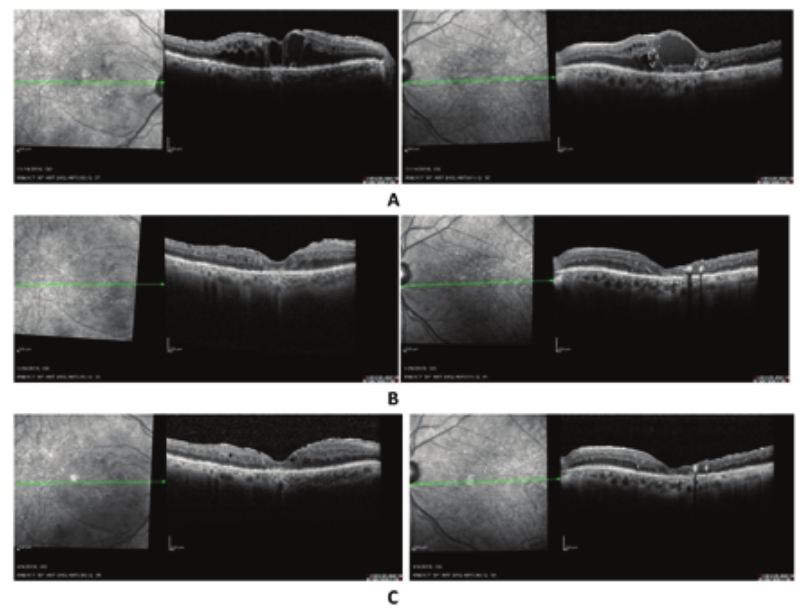
Figure 1. (A) Shows the optical coherence tomography (OCT) raster horizontal line passing through the center of the macula in right (upper left) and left eye (upper right) before starting topical interferon alpha 2b treatment . (B) and (C) are OCTs at one- and three-month follow-up visits, respectively, in the right (left picture) and left (right picture) eyes. In this case, tapering of the drop was started at eight weeks.